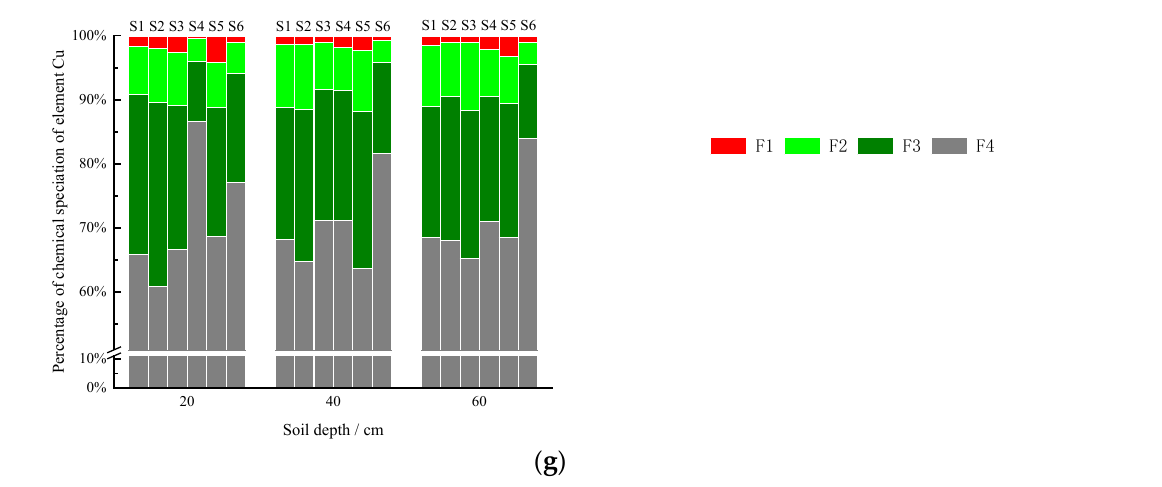
Figure 3. Percentage of Heavy metal speciation in the soil samples from the An-tea plantations ( a ) Cu, ( b ) Cd, ( c ) Ni, ( d ) Zn, ( e ) As, ( f ) Pb, and ( g ) Cu.